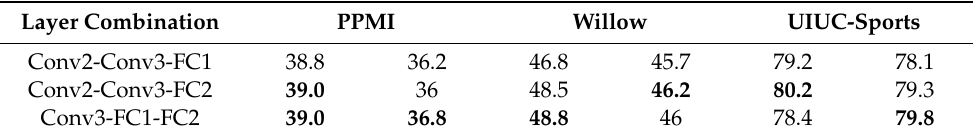
Table 7. Classification accuracy (%) of the teacher and student networks. For each dataset, the first column is for the teacher network and the second column is for the student network. Three layers of the student network are bound to Conv5, FC1, and FC2 layers in the teacher network.